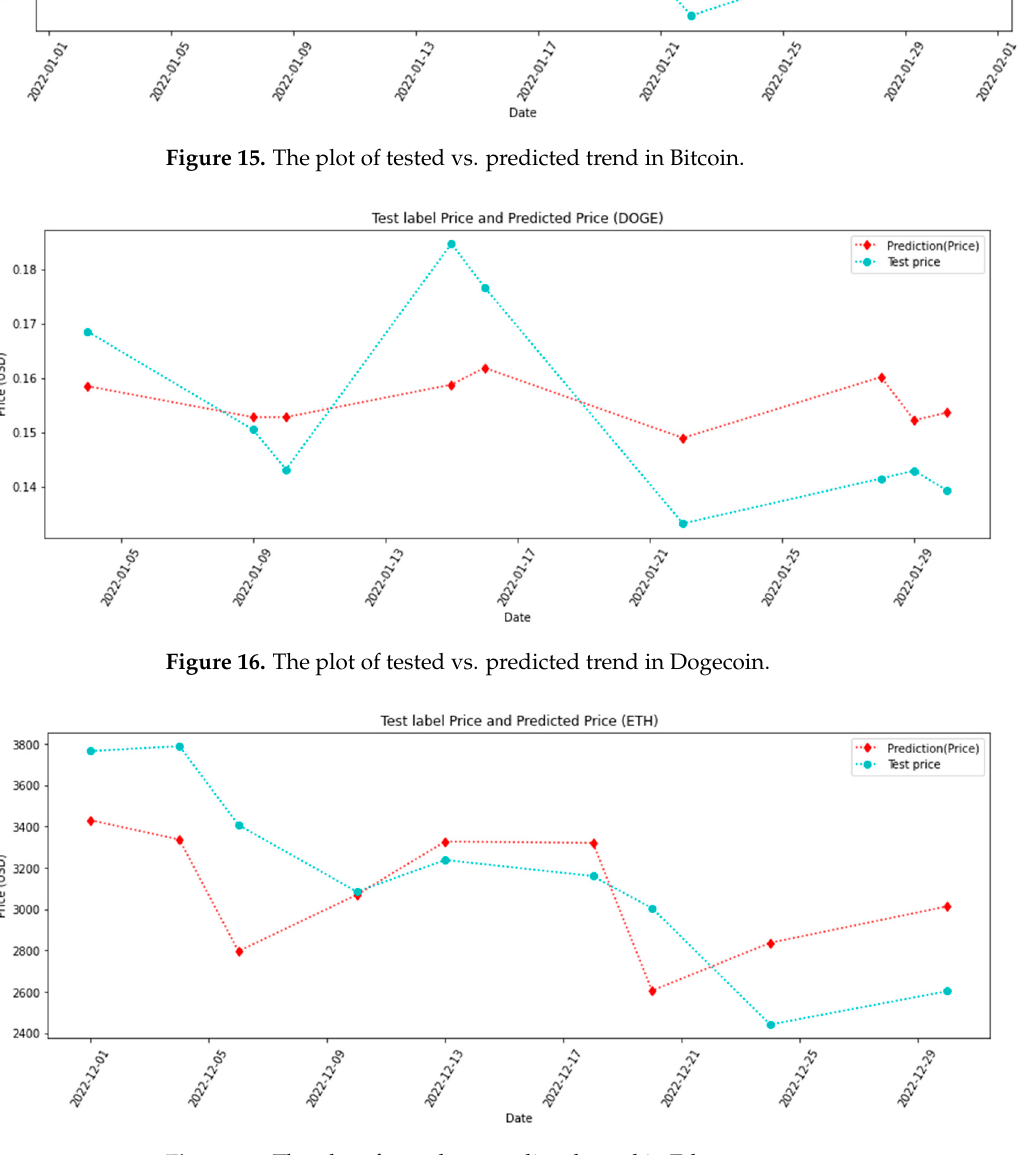
Figure 17. The plot of tested vs. predicted trend in Ethereum. Table 7. Trading signal accuracy. Table 7. Trading signal